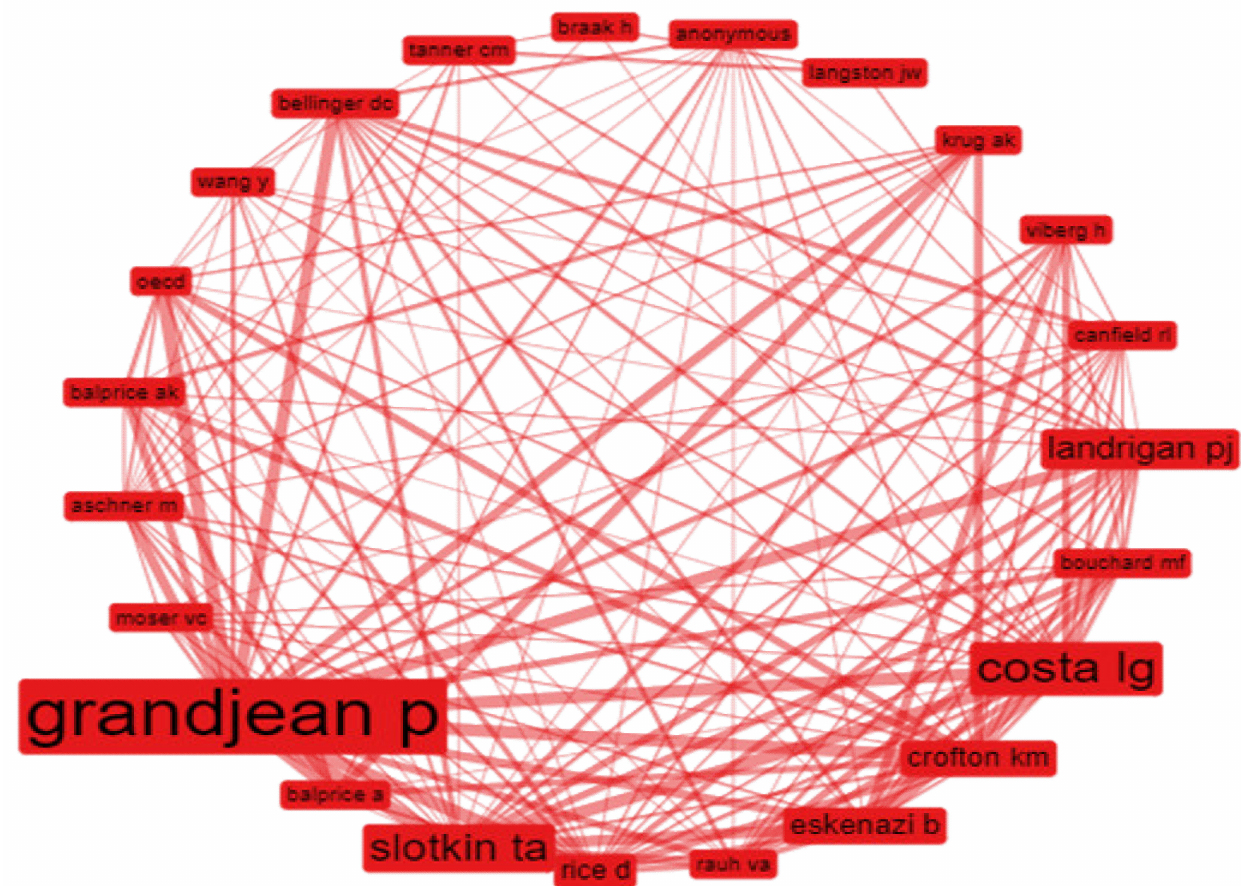
Figure 5. Authors’ co-citation analysis between 2011 and